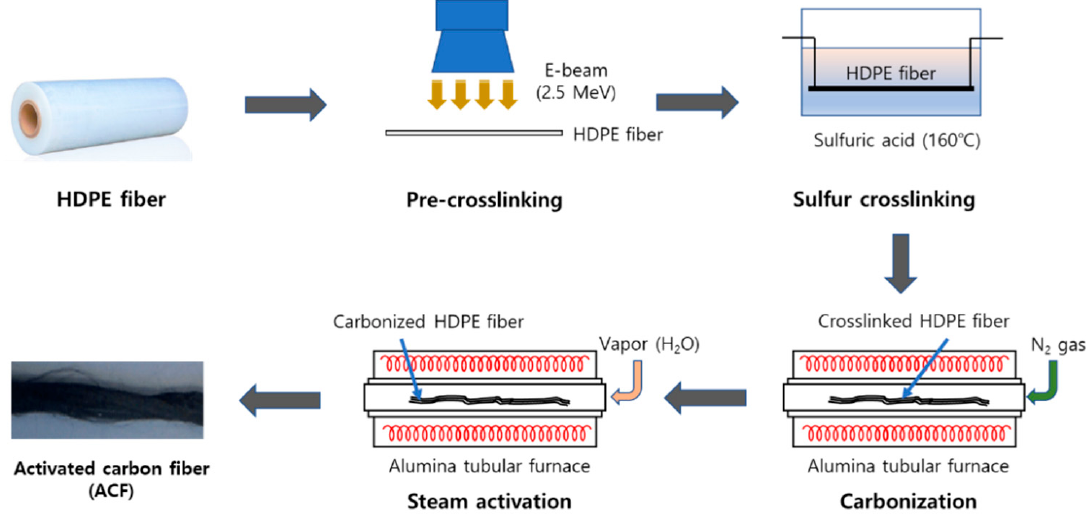
Figure 1. Preparing process diagram of activated carbon fiber using high-density polyethylene fiber.